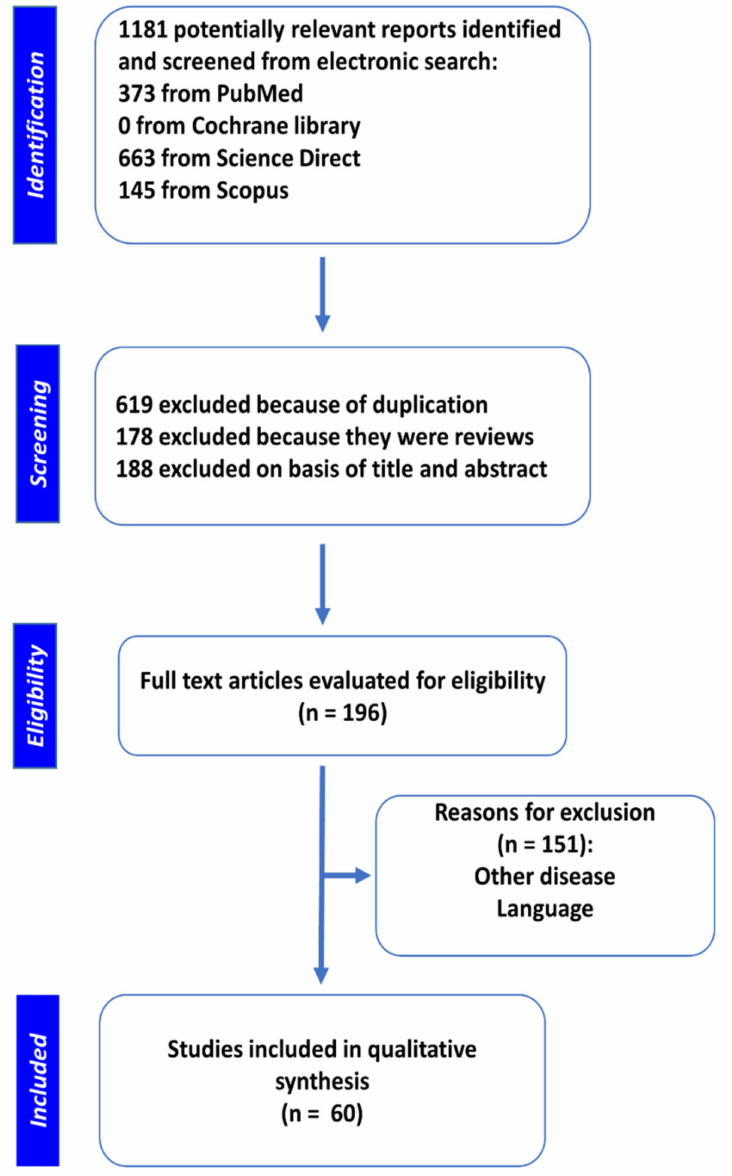
Figure 1. Flow diagram of literature exploration and